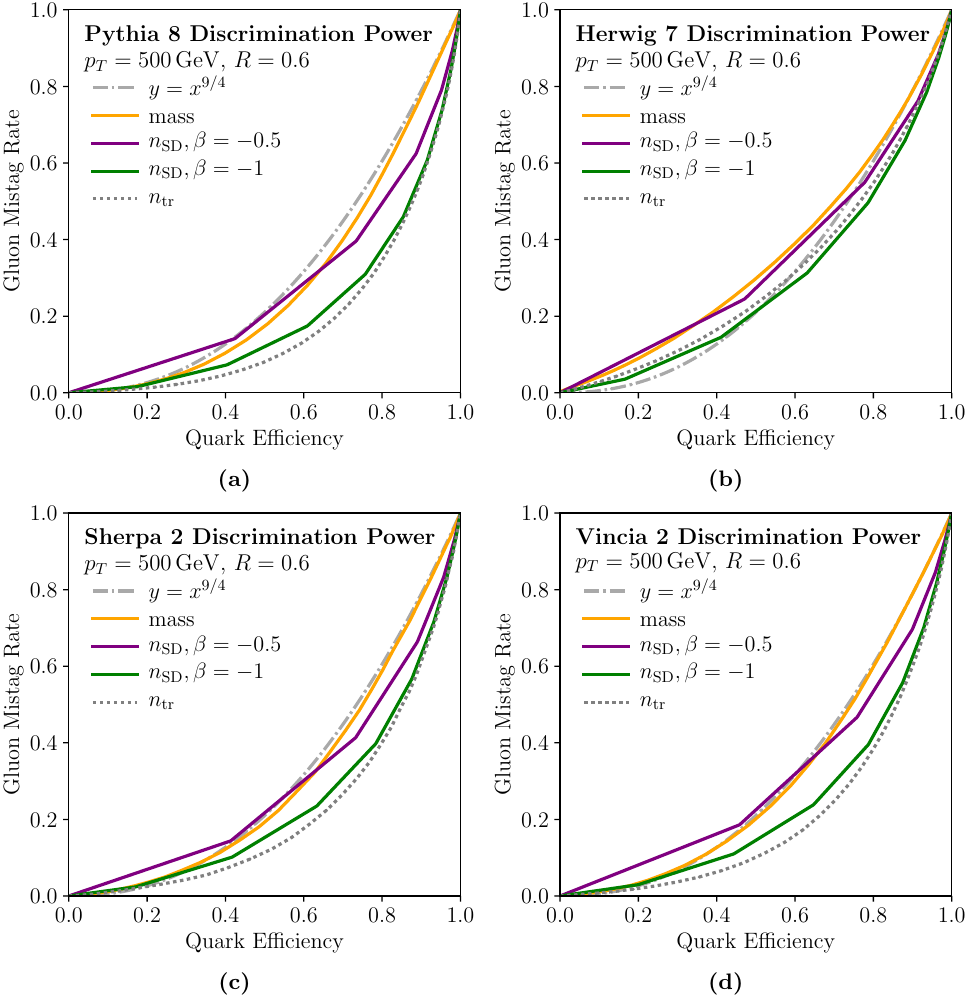
Figure 13. Predicted quark/gluon discrimination power from (a) Pythia 8.219, (b) Herwig 7.0.1, (c) Sherpa 2.2.0, and (d) Vincia 2.0.01. While the generators disagree about absolute performance, they agree that n SD with (cid:12) = 1 outperforms jet mass and approaches the (cid:0) discrimination power of n tr